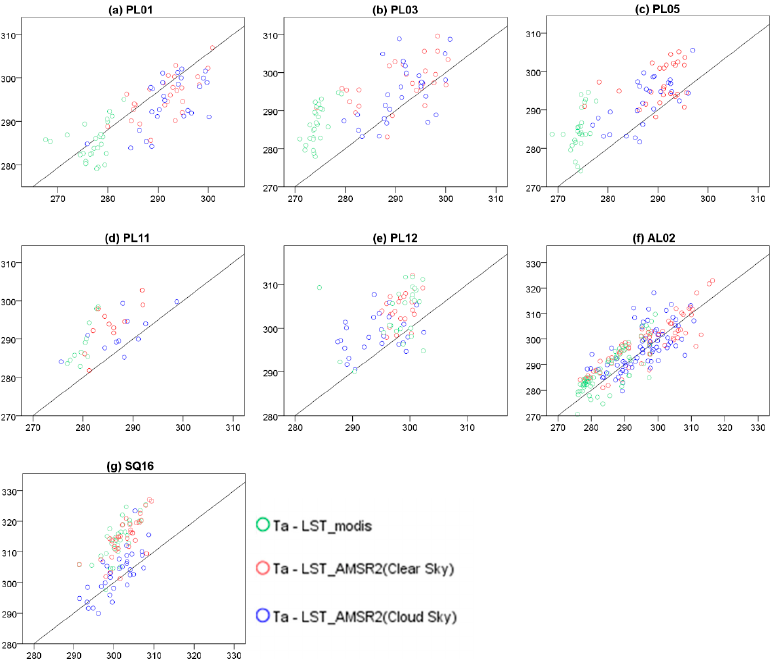
Figure 15. Scatter plot between in situ soil temperature and LST_modis, and LST_AMSR2 under clear and cloudy conditions. ( a ) PL01. ( b ) PL03. ( c ) PL05. ( d ) PL11. ( e ) PL12. ( f ) AL02. ( g ) SQ16. Table 5. R and RMSE between predicted LST and soil temperature. Site